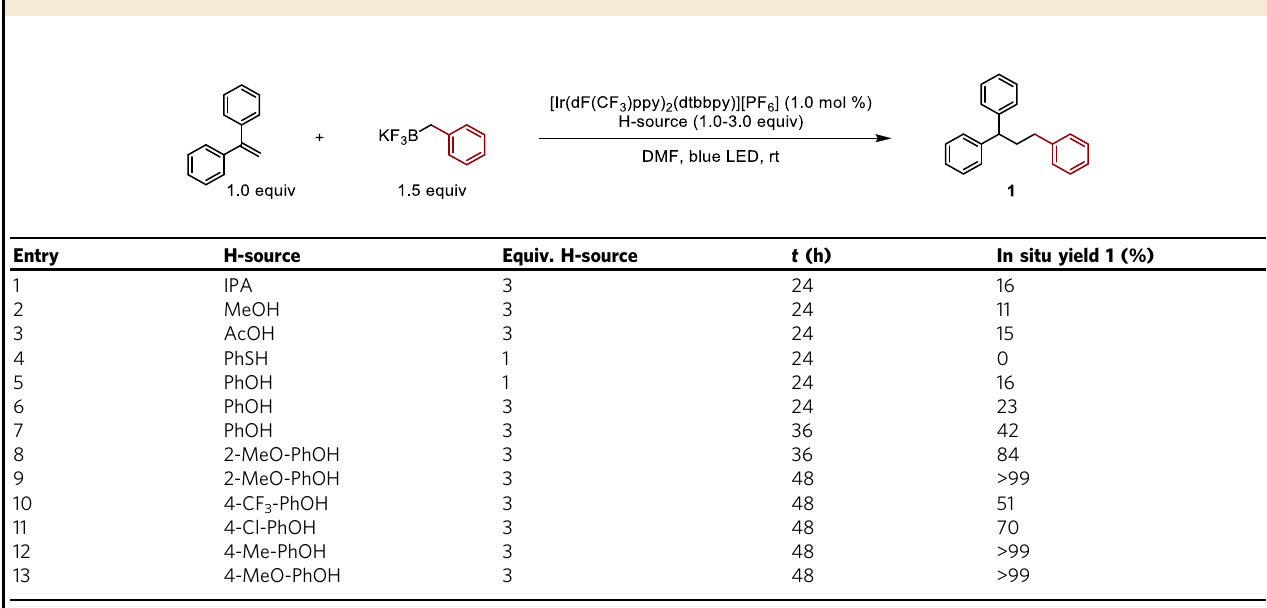
Table 1 Select optimization results for the hydroalkylation reaction a